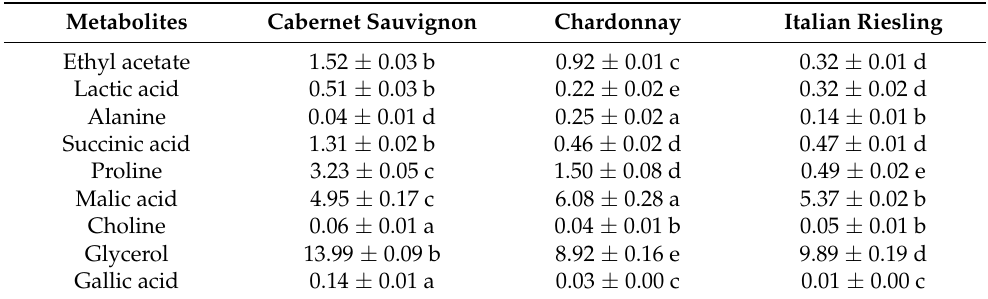
Table 2. Content of main metabolites in Cabernet Sauvignon dry red wine, Chardonnay, Italian Riesling dry white wine